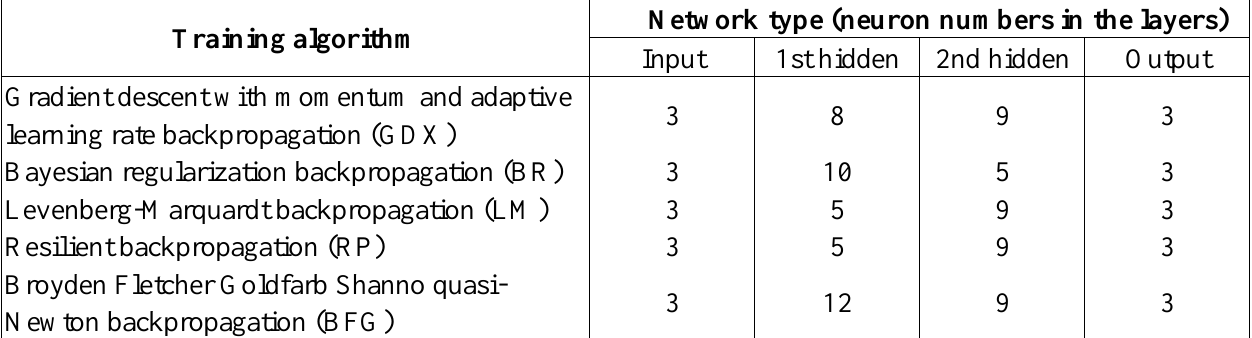
Table 2. Network structures of the proposed models